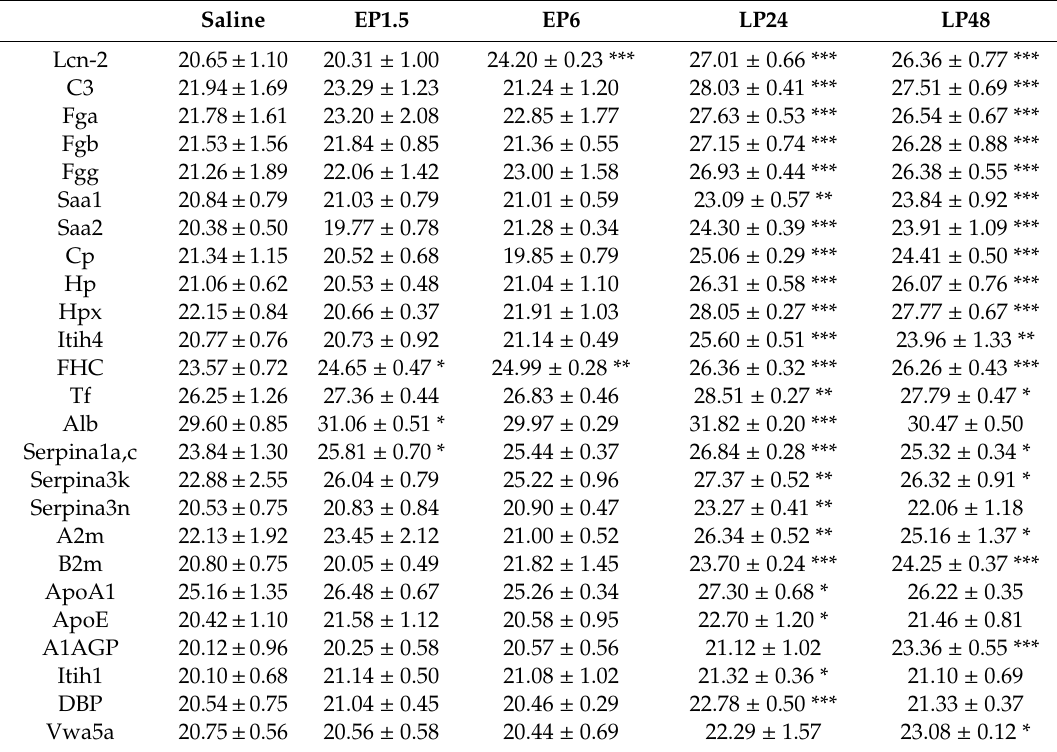
Table 3. Log2 transformed label-free quantification (LFQ) intensity values of APPs determined by mass spectrometry in the kidneys of mice after LPS administration. Values are given as mean ± standard deviation (SD). *: p < 0.05, **: p ≤ 0.01, ***: p ≤ 0.001. EP (1.5 and 6 h) and LP (24 and 48 h) were statistically analysed separately (double line). Lcn-2: lipocalin-2, C3: complement C3, Fga: fibrinogen- α , Fgb: fibrinogen- β , Fgg: fibrinogen- γ , Saa: serum amyloid A, Cp: